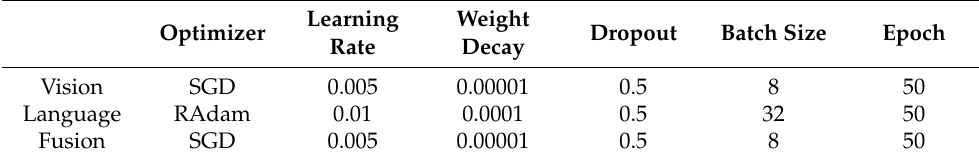
Table 1. The training parameters of each module of the model.